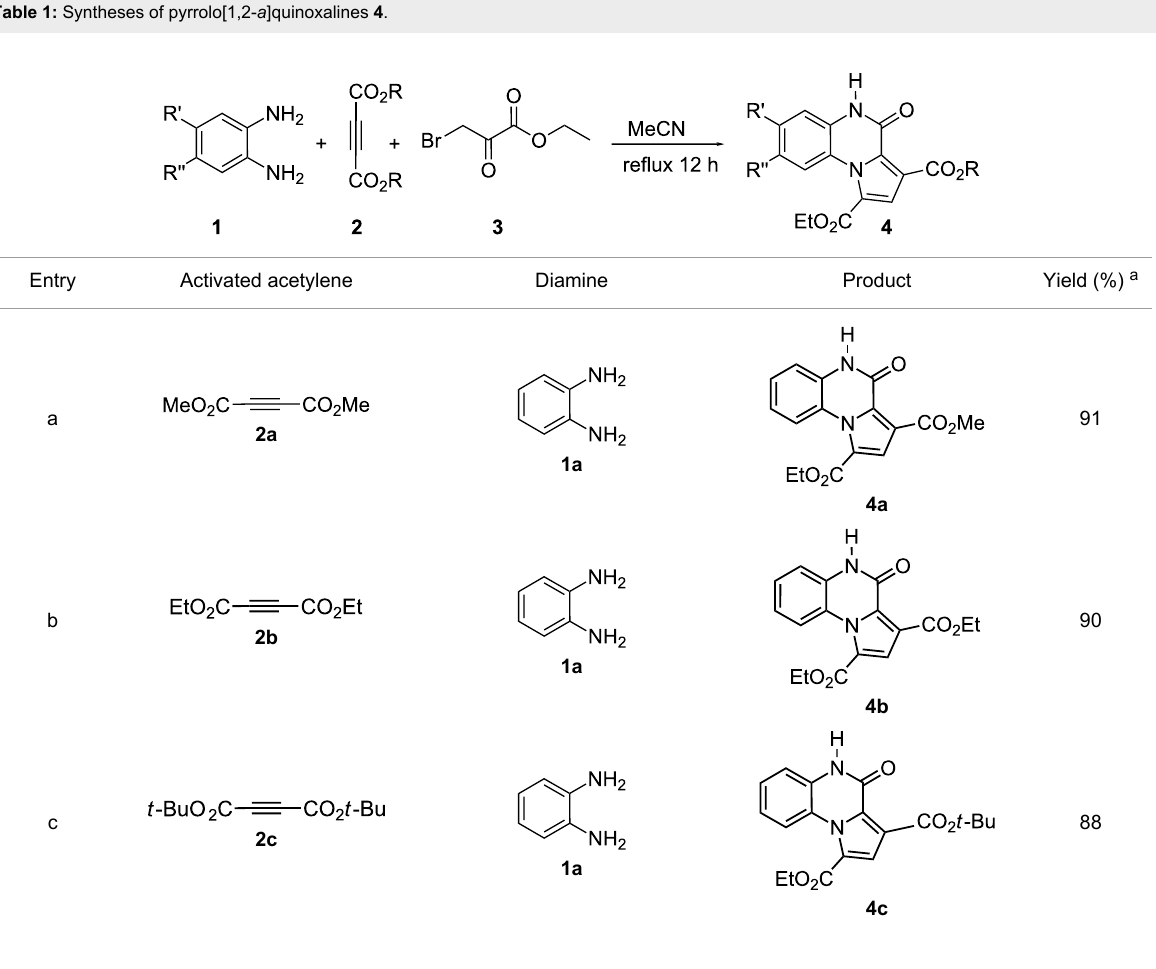
Table 1: Syntheses of pyrrolo[1,2- a ]quinoxalines 4